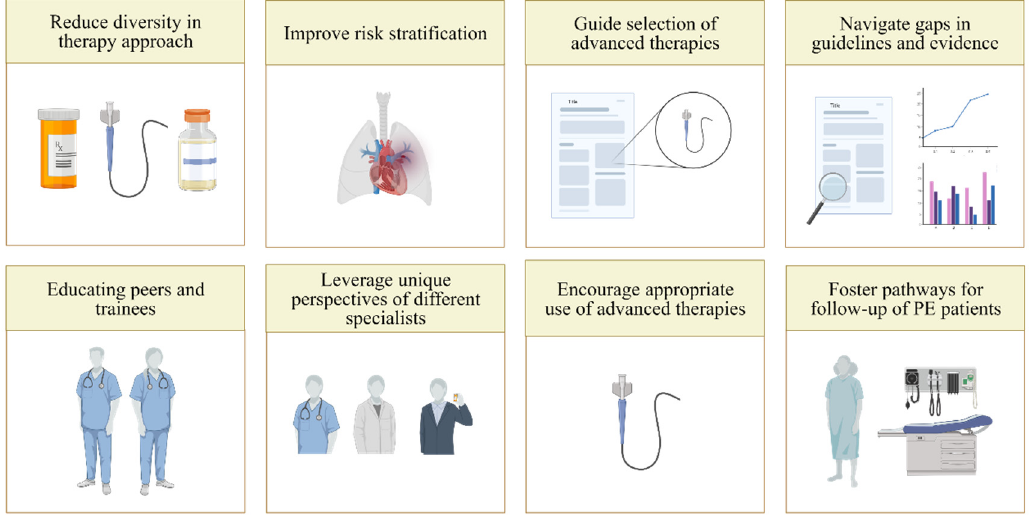
Figure 1. The rationale for pulmonary embolism response teams.